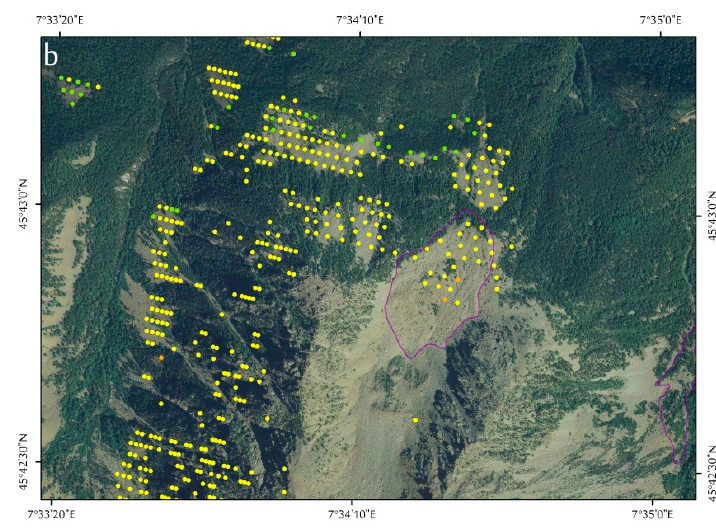
Figure 11. Mean deformation velocity map of La Clapey Gerbioz relict rock glacier for ( a ) Envisat ascending orbit and ( b ) descending orbit.